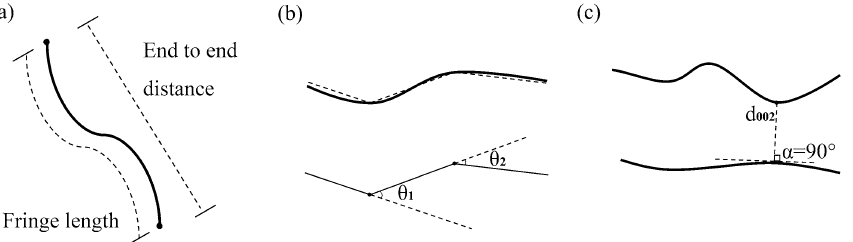
Figure 2. Illustrations for calculating the ( a ) fringe length and tortuosity, ( b ) degree of curve ( c ) interlayer spacing (d 002 ).